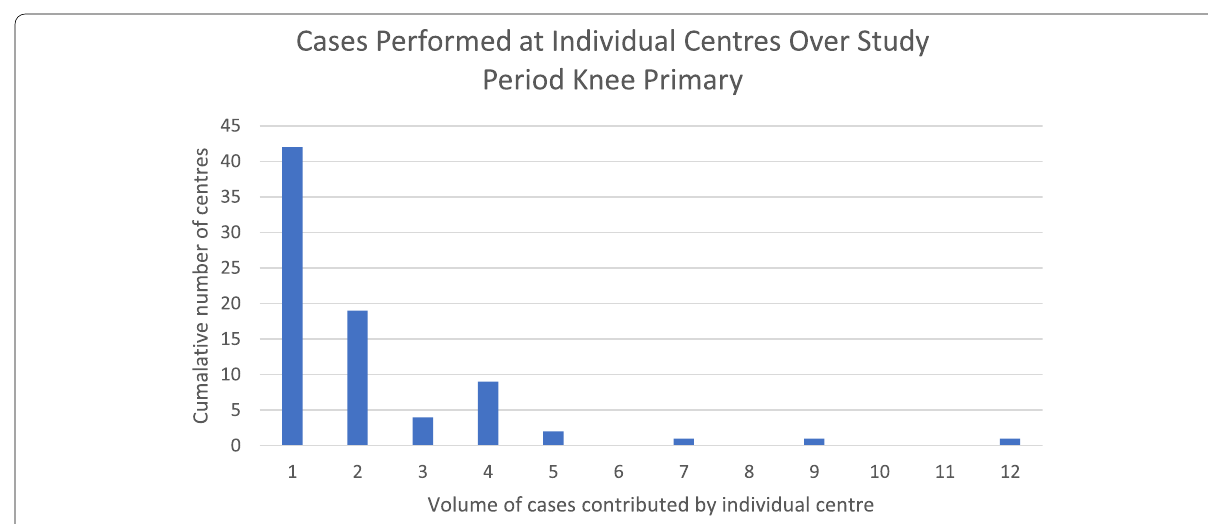
Fig. 7 Trends in femoral megaprosthesis use for trauma indications